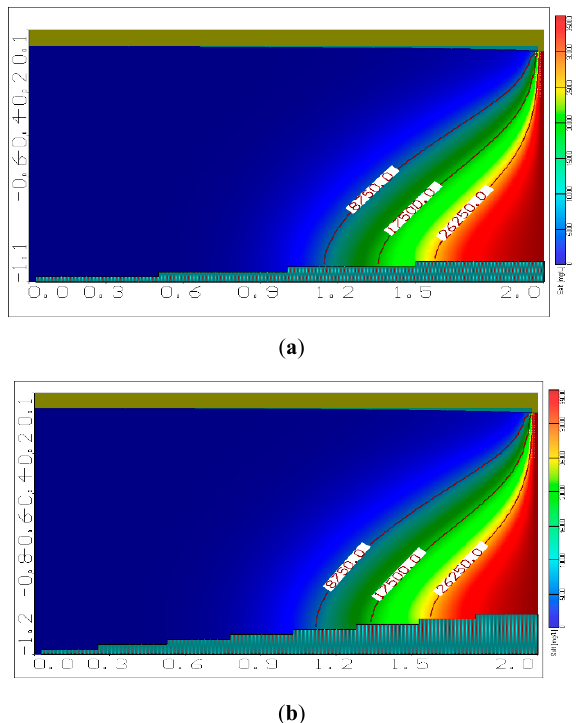
Figure 10. Saltwater intrusion for different bed slopes toward the seaside ( a ) 20:1 and ( b ) 10:1 .